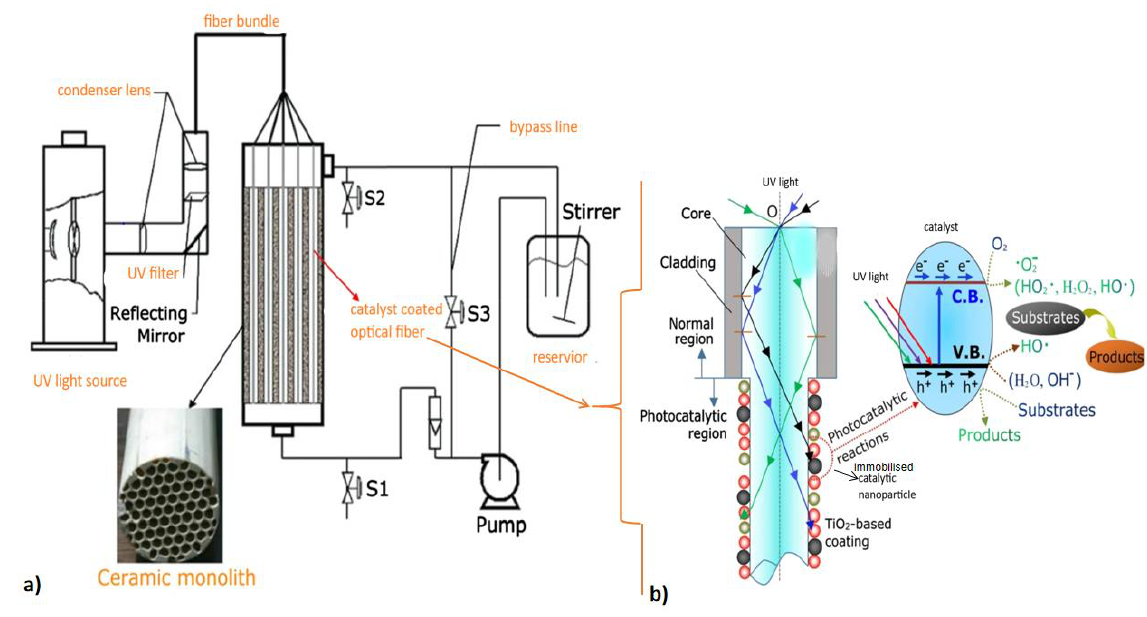
Figure 11. Ceramic PMR with optical fiber system ( a ), reproduced with permission from [174], Copyright 2005 Springer; and the mechanism of light transmission in photocatalytic optical fibers ( b ), reproduced with permission from [188], Copyright 2011 Springer.